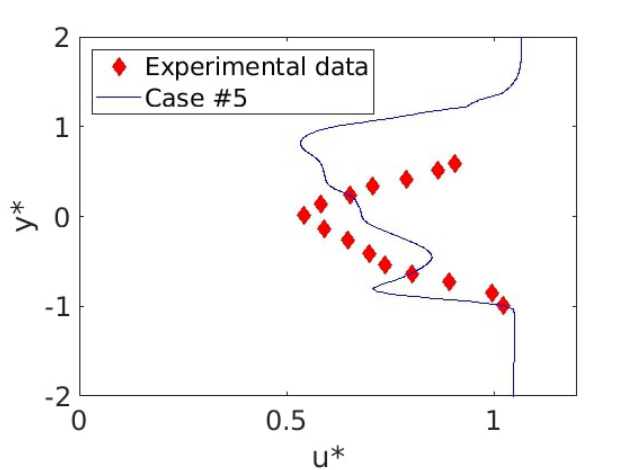
Figure 25. u ∗ depending on the y ∗ position comparison between case #5 (blue line) and experimental data (red lozenges) at x ∗ = 2.